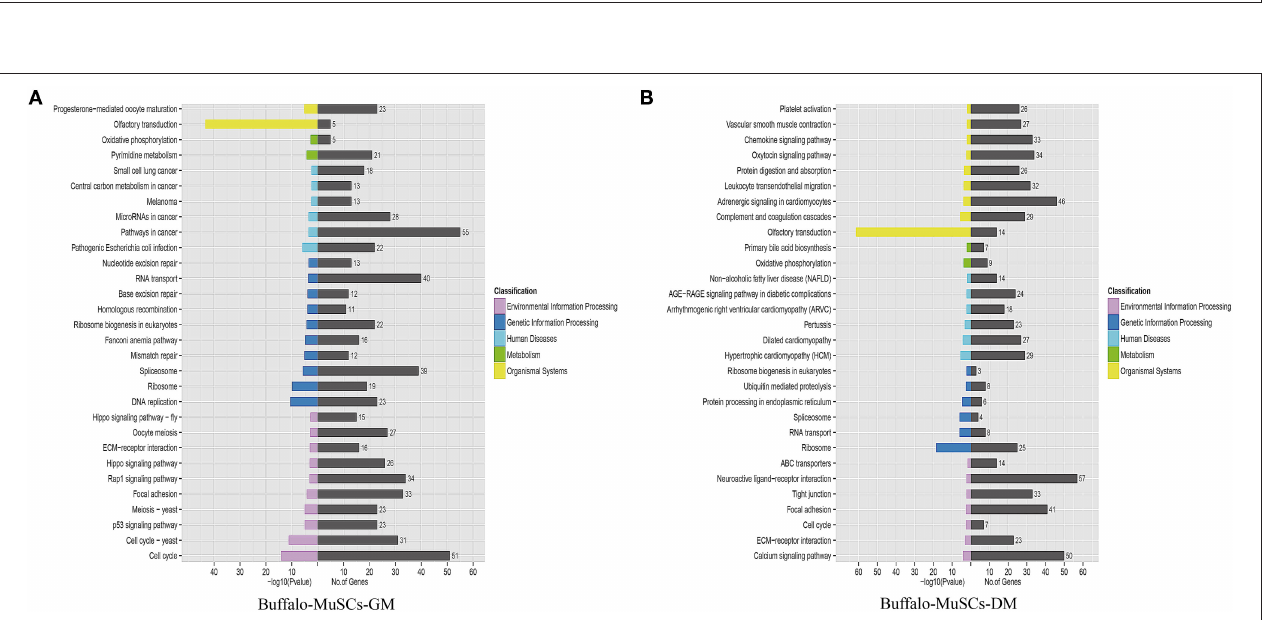
FIGURE 4 | Kyoto Encyclopedia of Genes and Genomes pathway analysis. (A) Top 30 KEGG terms of DEGs in the GM samples of MuSCs. (B) Top 30 KEGG terms of DEGs in the DM samples of MuSCs.